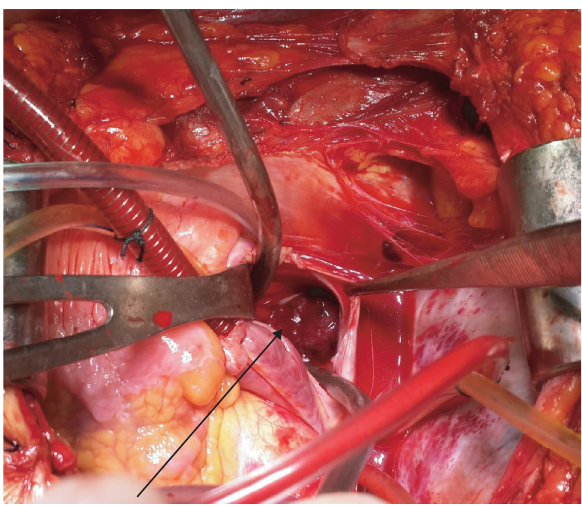
Figure 4: Opening of right atrium with arrow showing thrombus in situ.